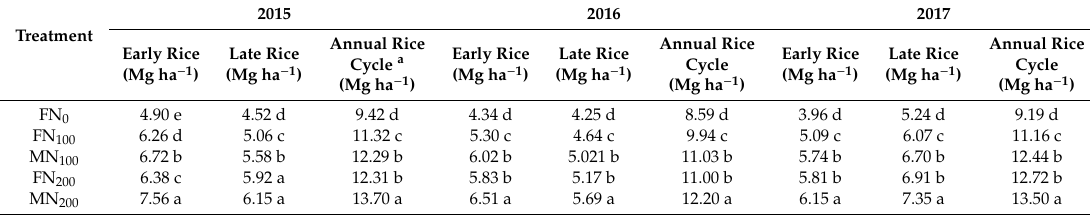
Table 2. Grain yields for the early rice, late rice, and annual rice cycle in the years 2015–2017 influenced by vetch